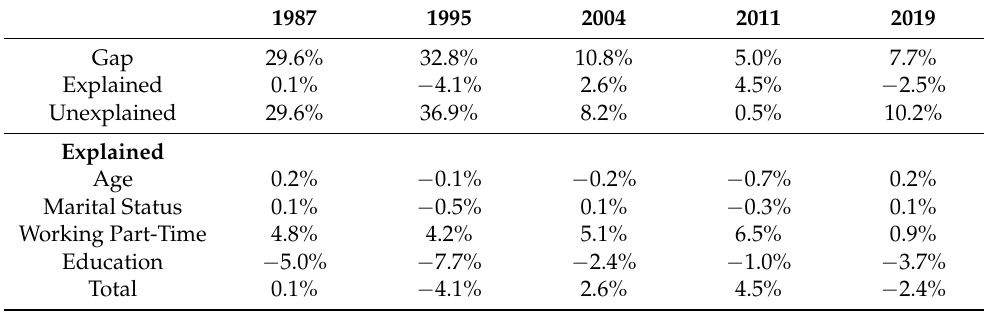
Table A3. Decomposition results from RIF regressions for selected years at the 10th